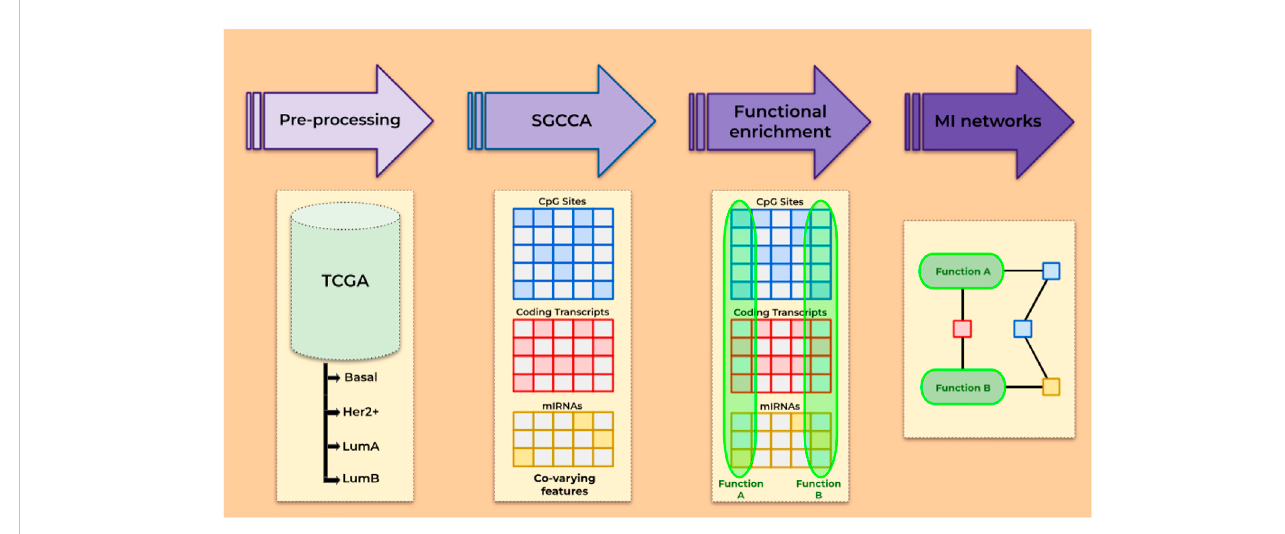
FIGURE 1 Overview of the steps followed.